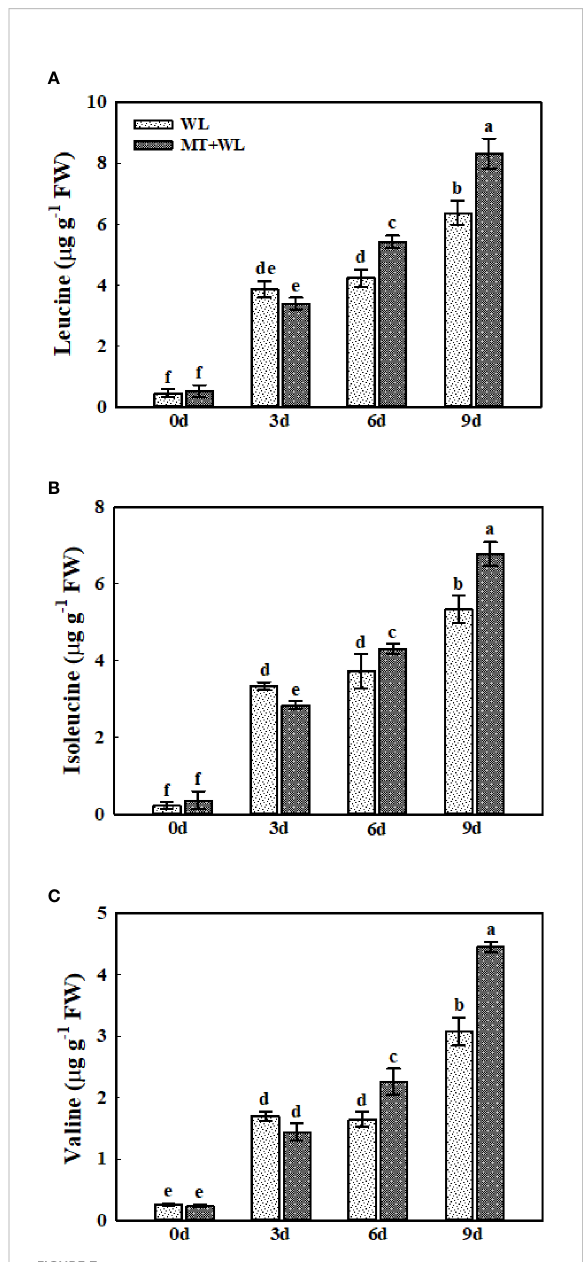
FIGURE 7 Change to "The concentrations of Leu, Ile, and Val in the roots of kiwifruit plants under waterlogging stress, as measured by LC- MS. (A) Leu. (B) Ile. (C) Val. Data are shown as the means of three replicates with SEs. Different letters indicate signi fi cant differences between treatments, according to one-way ANOVA and Tukey ’ s multiple range test (P <